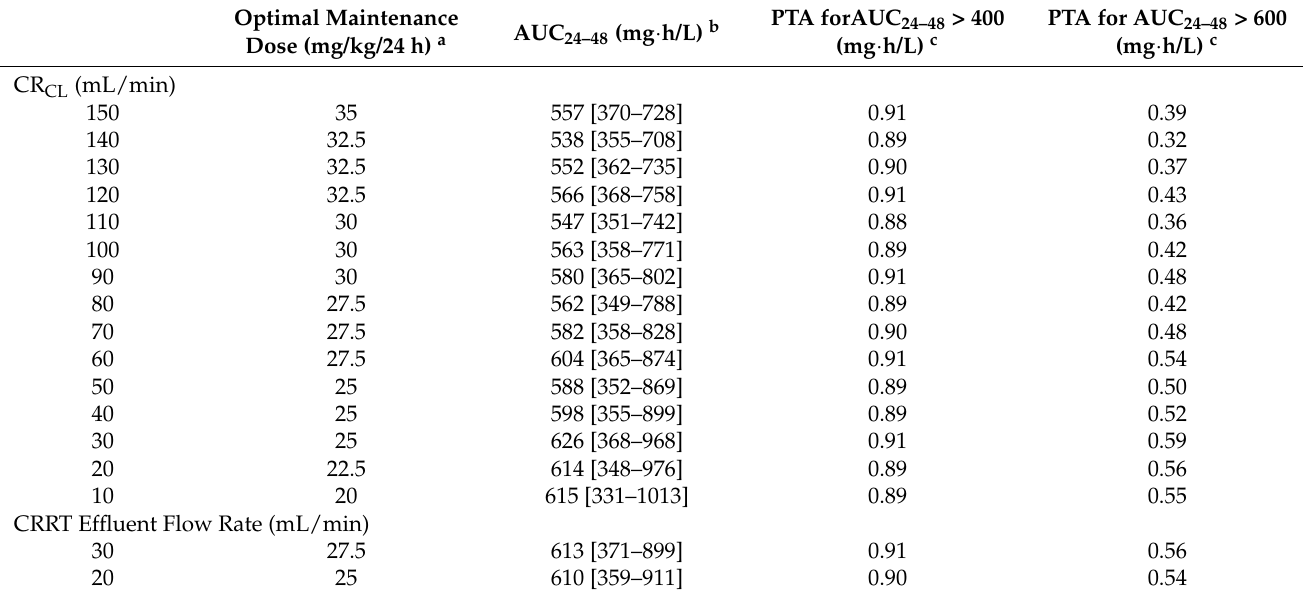
Table 4. PK/PD simulation for probability of target attainment >